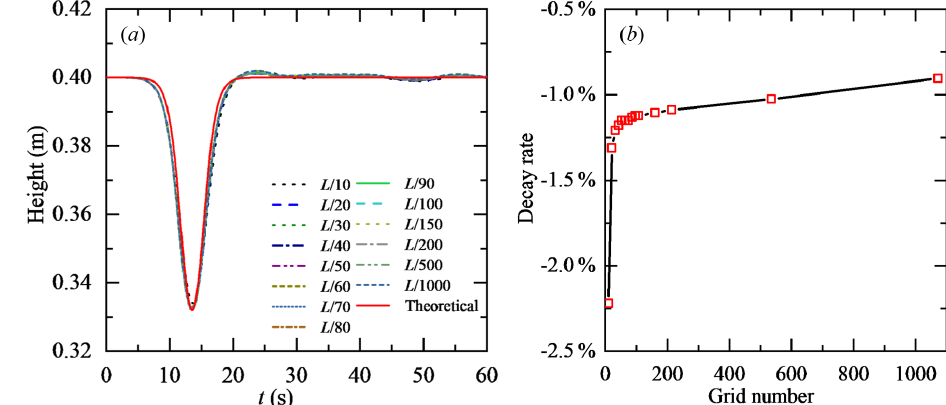
Figure 4. Grid independence in the horizontal direction at probe P1: (a) comparison of waveform and (b) decay rate.